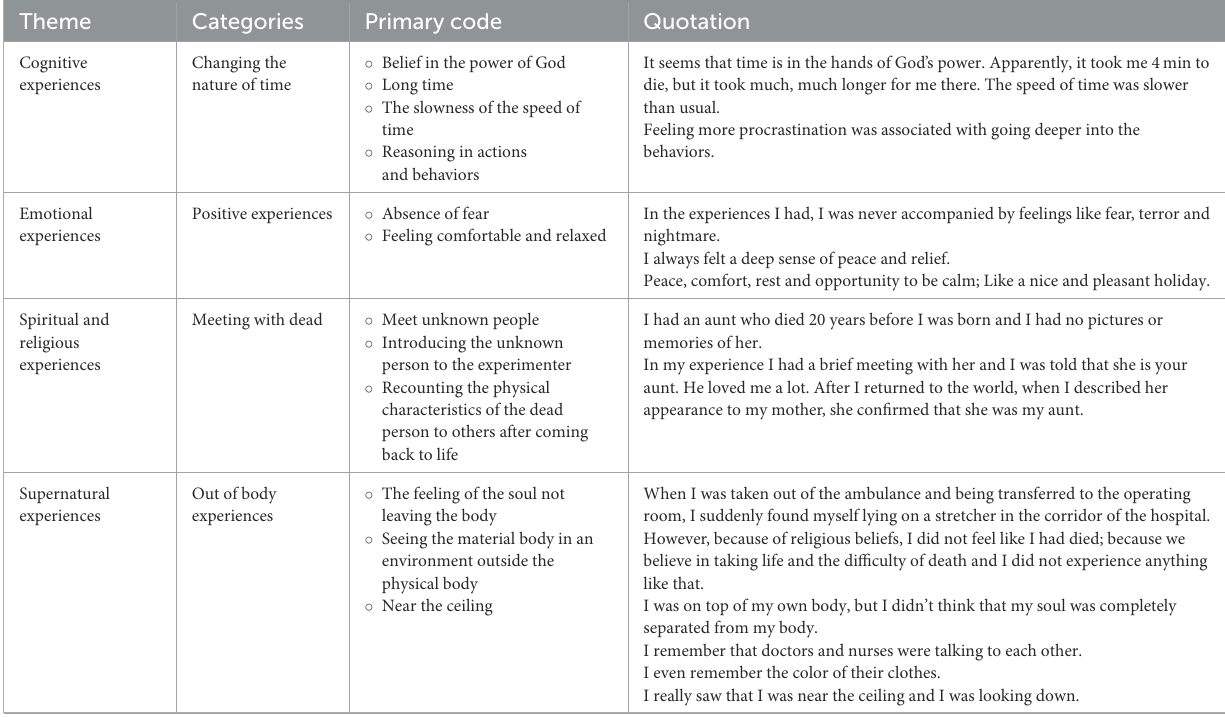
TABLE 1 An example of data analysis in the main